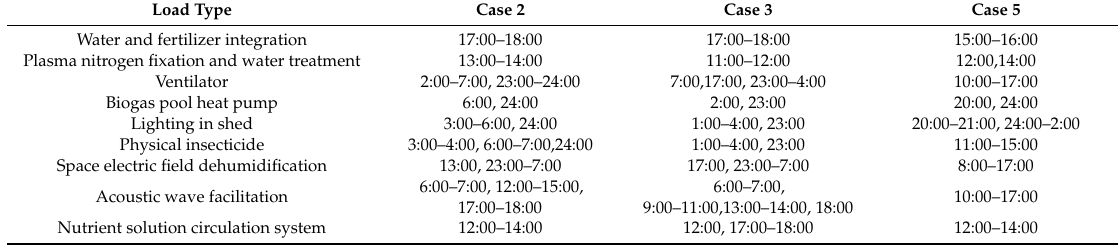
Table 14. The input time schedule of time-shifting load.